Question: Compose a caption that would accompany this figure in a paper.
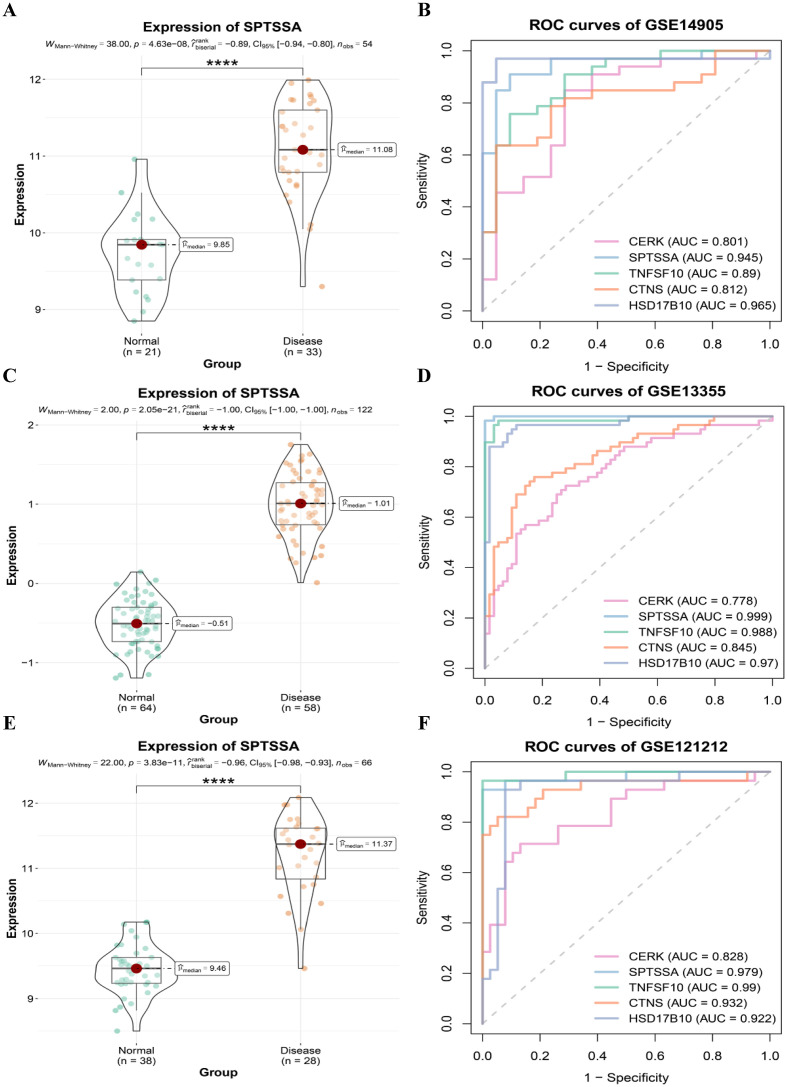
Answer: Cross-cohort validation of candidate hub genes. (A) Differential expression of candidate genes in GSE14905 . (B) ROC curves in GSE14905 . (C) Differential expression in GSE13355 . (D) ROC curves in GSE13355 . (E) Differential expression in GSE121212 . (F) ROC curves in GSE121212 . ****P < 0.0001.